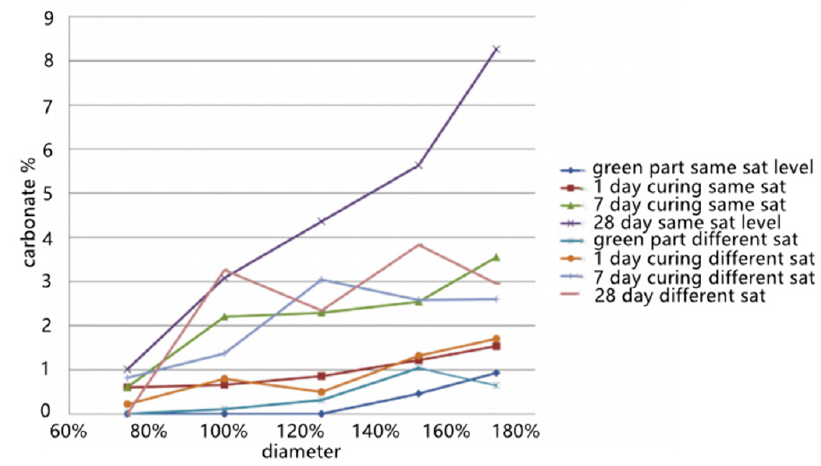
Figure 8. Compressive strength of 3DP cubic samples with lithium carbonate. Reprinted with permission from ref. [29]. Copyright 2017 Elsevier Ltd.